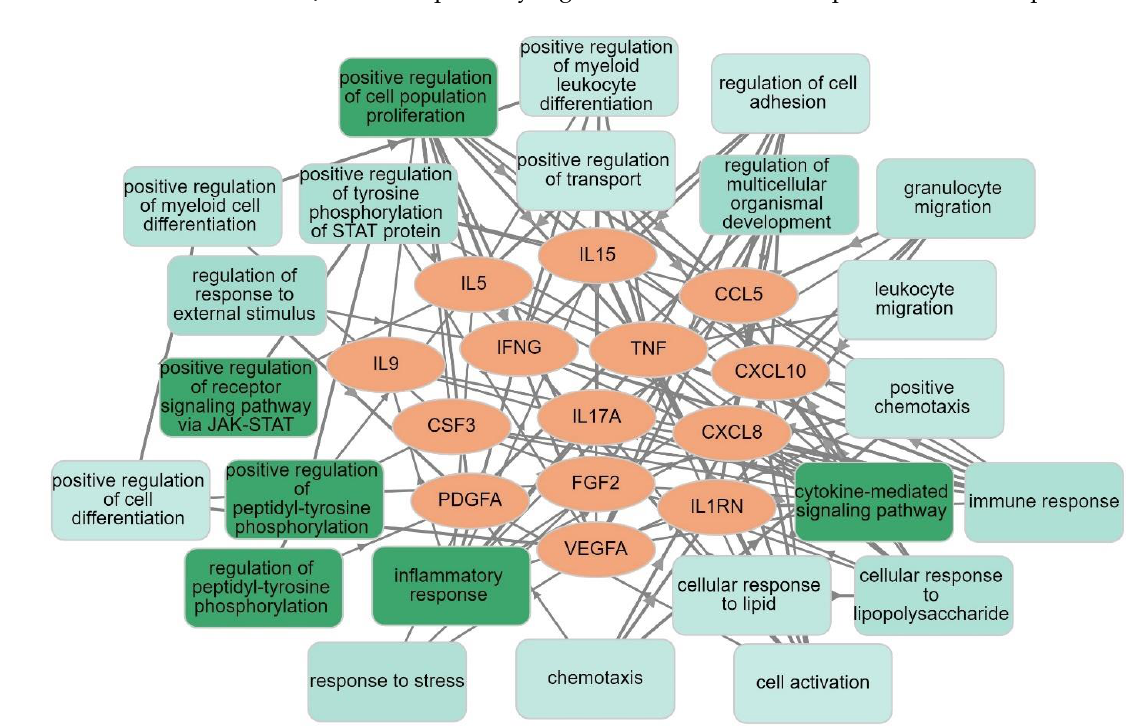
Figure 7. Results of GOnet enrichment analysis showing the 14 seed differentially expressed proteins of major dysmood disorder and their significant GO annotations. Table 5. KEGG pathway classifications of the differently expressed proteins (DEPs) in major dys- mood disorder.